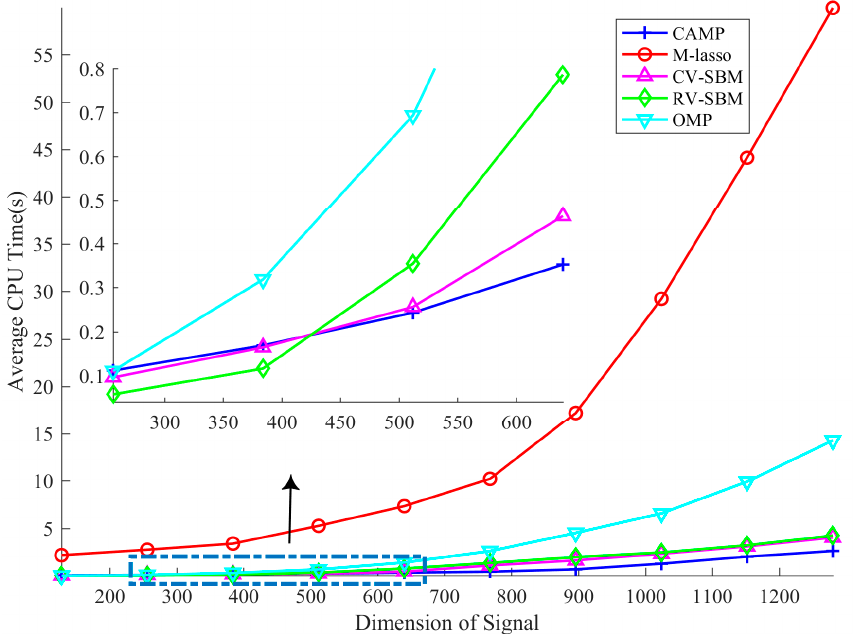
Figure 5. Average CPU time cost in different signal dimensions.